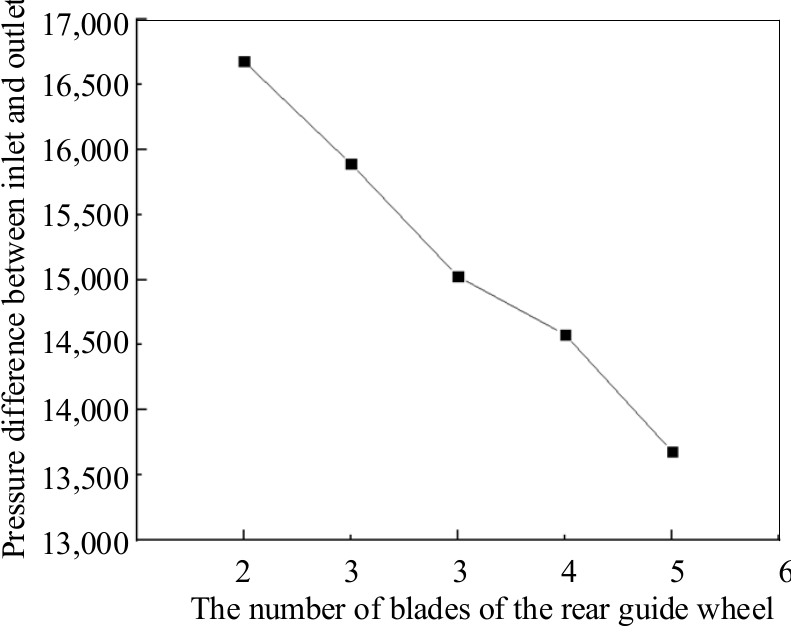
Figure 9. Relationship between the number of blades of the rear guide wheel and the outlet pressure. The flow channel was changed by varying the number of blades of the rear guide wheel. As shown in Figure 9, the outlet pressure was negatively correlated with the number of blades of the rear guide wheel. Meanwhile, the inlet pressure was 24,751.6 Pa. Thus, the rear guide wheel played a role in the resistance to the blood flow. According to theoretical analysis, the points in Figure 9 should be in a straight line. The point corresponding to four blades exhibited a small offset from this line, possibly because the number of iterations calculated by the simulation was insufficient. Each group of simulations was carried out under the same conditions, with only the number of blades being changed, and yet the convergence conditions corresponding to different blade numbers were not the same. In order to reduce the energy loss of the blood flow, it is necessary to select a reasonable number of blades. As shown in Figure 10, which presents the streamline distribution and turbulent viscosity under different numbers of blades, a mismatch between the number of blades and the flow channel caused turbulent blood